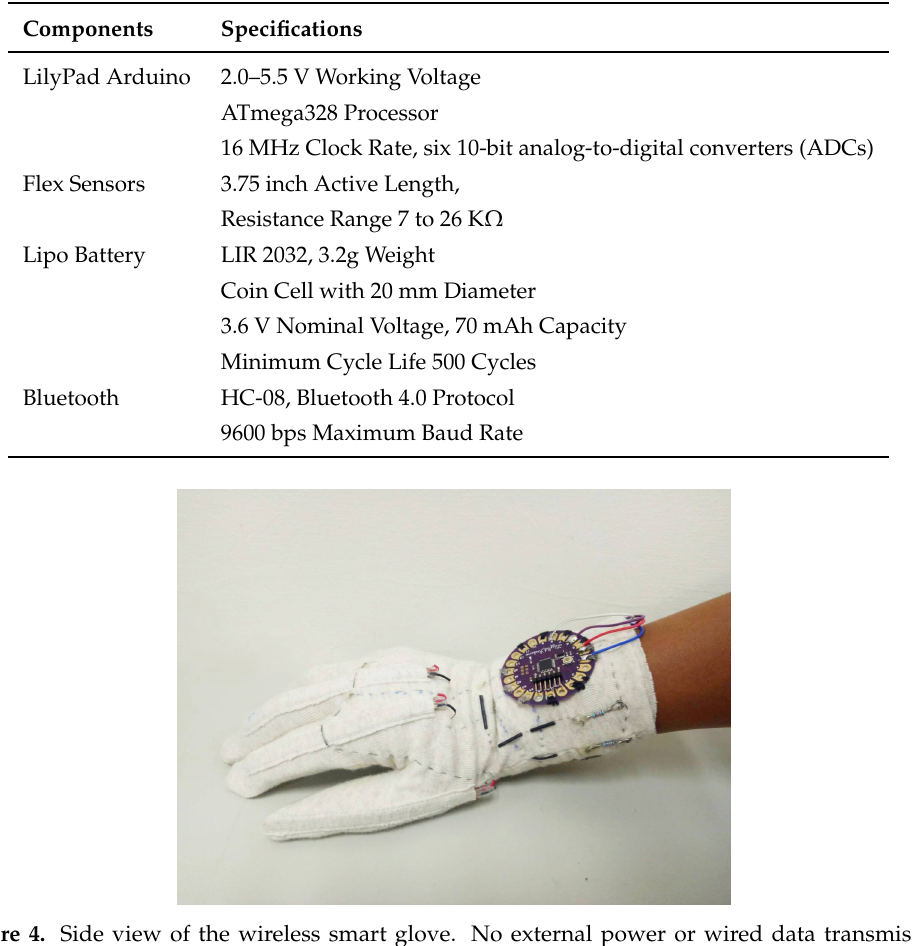
Figure 3. Layout of the wireless smart glove, which contains the flex sensors, Arduino Lilypad, Bluetooth module, conductive threads, and battery module. Table 1. Main Specifications of the components in the smart glove.